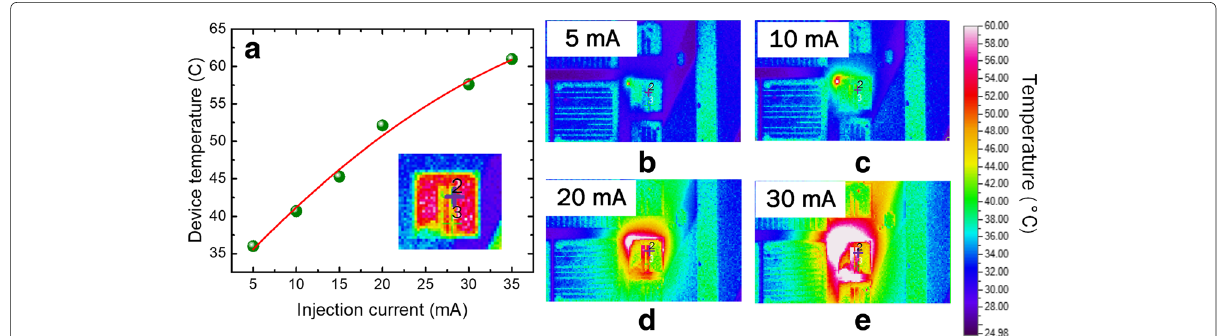
Fig. 6 Device temperature measurement using the OptoTherm infrared camera. a Change of device temperature with increasing injection current. Inset shows infrared image of the device structure under zero bias and adjusted color bar. The measurement point is indicated by the number 2 and the purple cross. Infrared image corresponding to the temperature of the device and surrounding area at injection current of b 5, c 10, d 20, and e 30 mA. The results indicate that heat is concentrated in the area around the